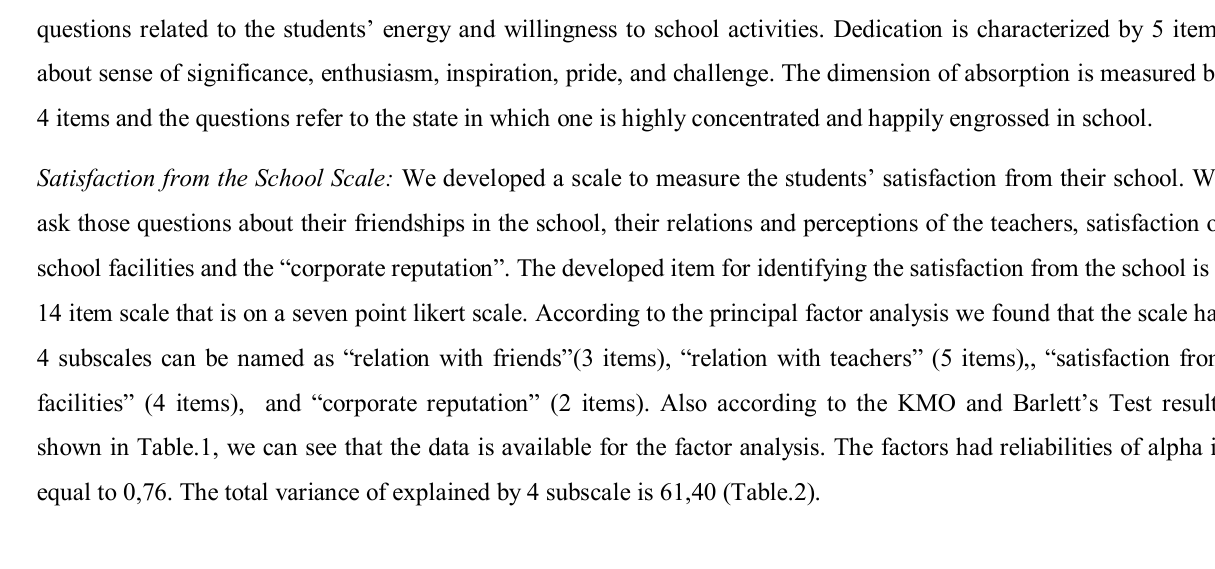
Table.1. KMO and Barlett’s Test Results